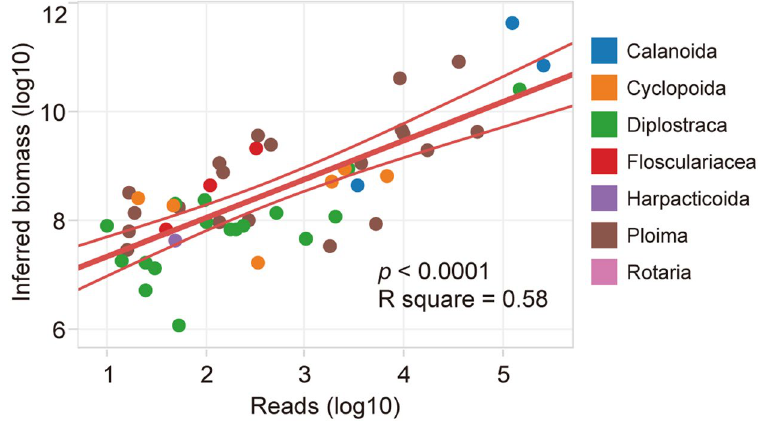
Figure 4. Relationship between inferred biomass of zooplankton in traditional monitoring data and the number of reads in metabarcoding data. The inferred biomass of zooplankton was roughly estimated by the density and body length (biomass = density × bodylength 3